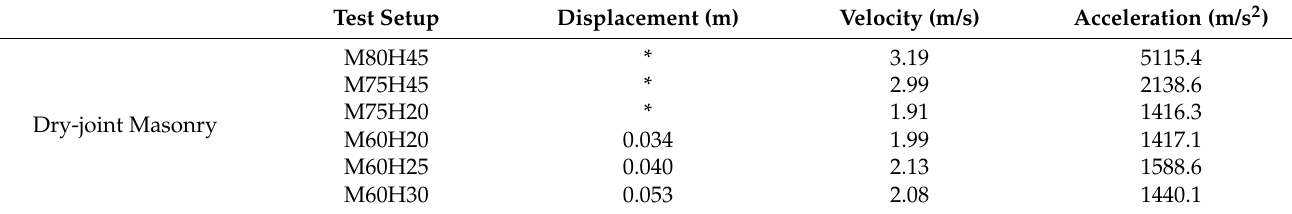
Figure 6. Status of the joint right at the moment of impact ( left ) and after the impact ( right ), retrieved from [35]. Table 3. Maximum vertical responses obtained at quarter span during the